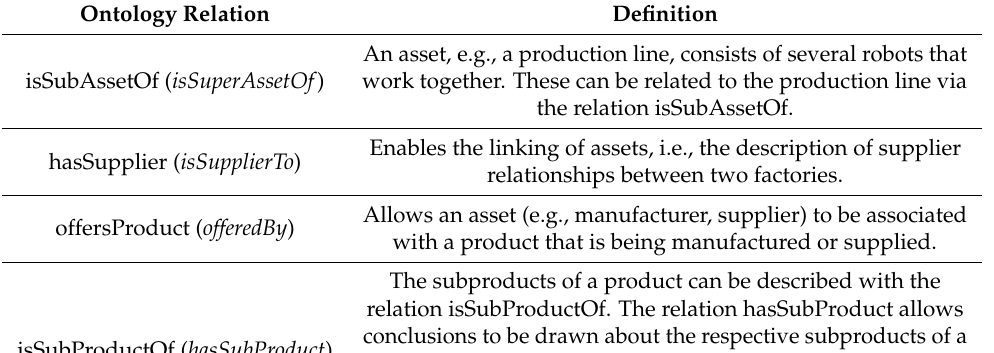
Table 6. Description of the ontology